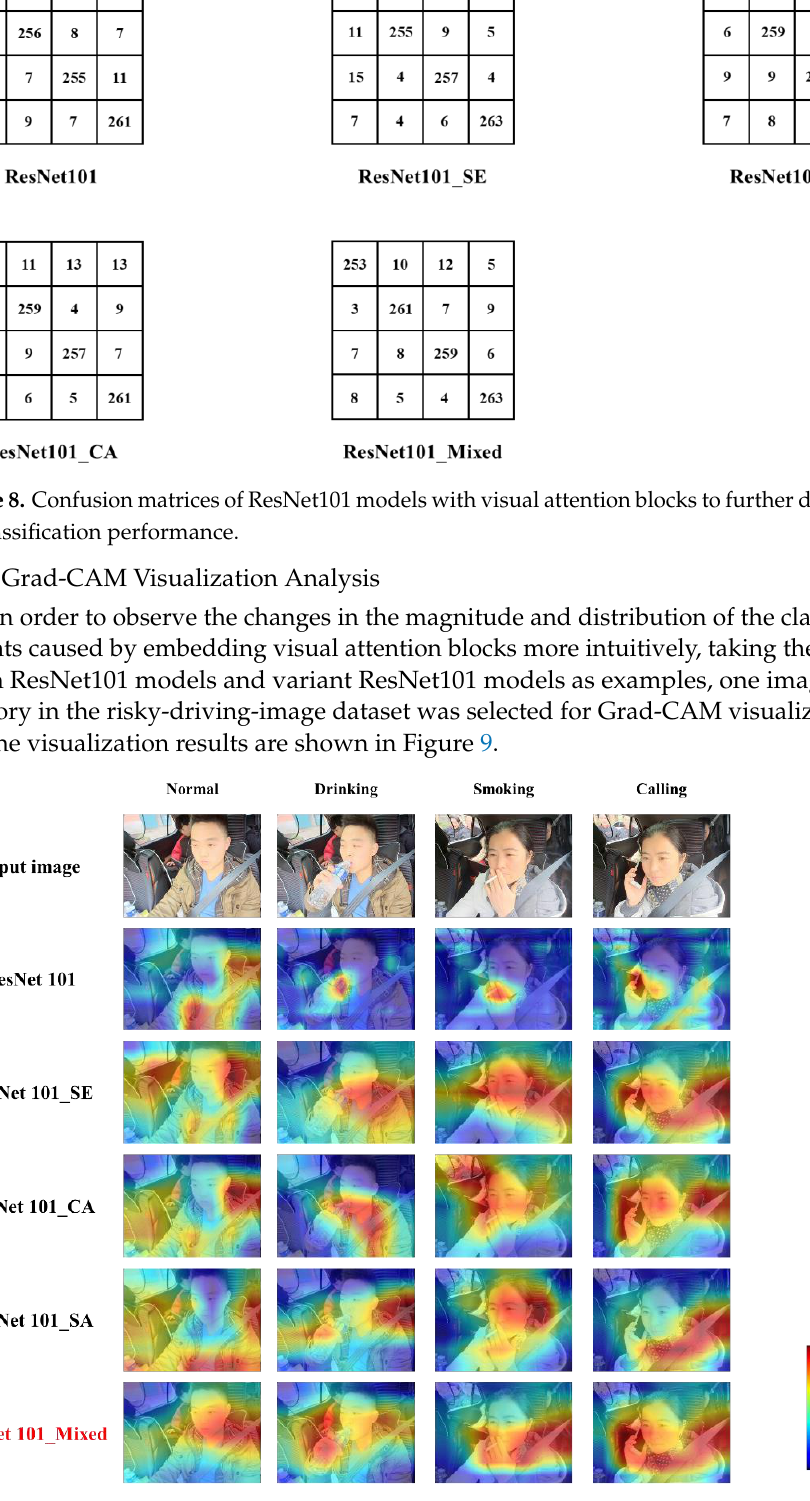
Figure 9. Grad-CAM maps of ResNet101 models with visual attention blocks to observe the changes in the magnitude and distribution of classification